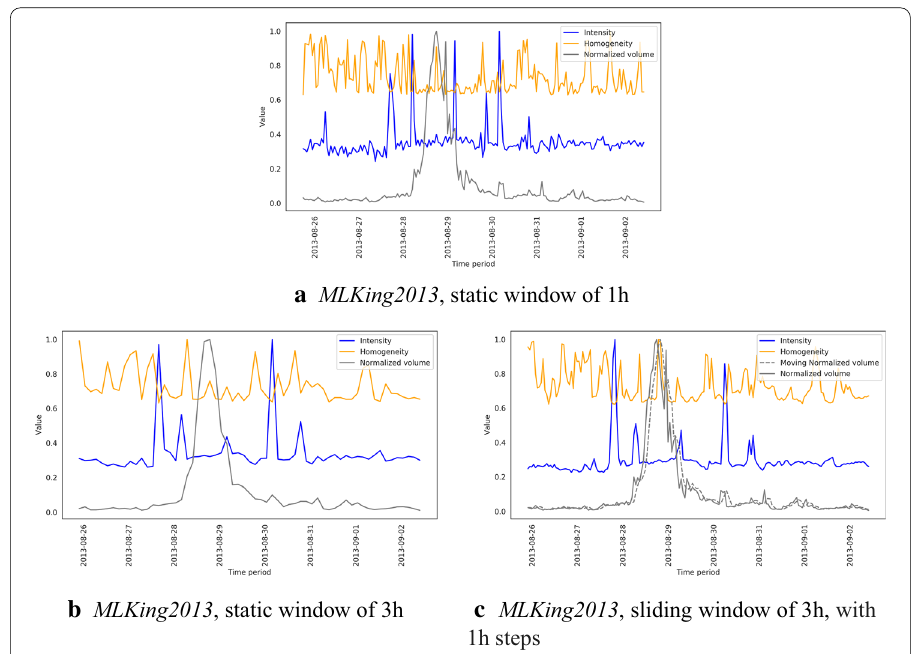
Fig. 16 Visualization of temporal entanglement across MLKing2013 . In grey, volume over the period of time (dotted line for the aggregated volume over sliding window ( c )). Intensity in blue and homogeneity in yellow